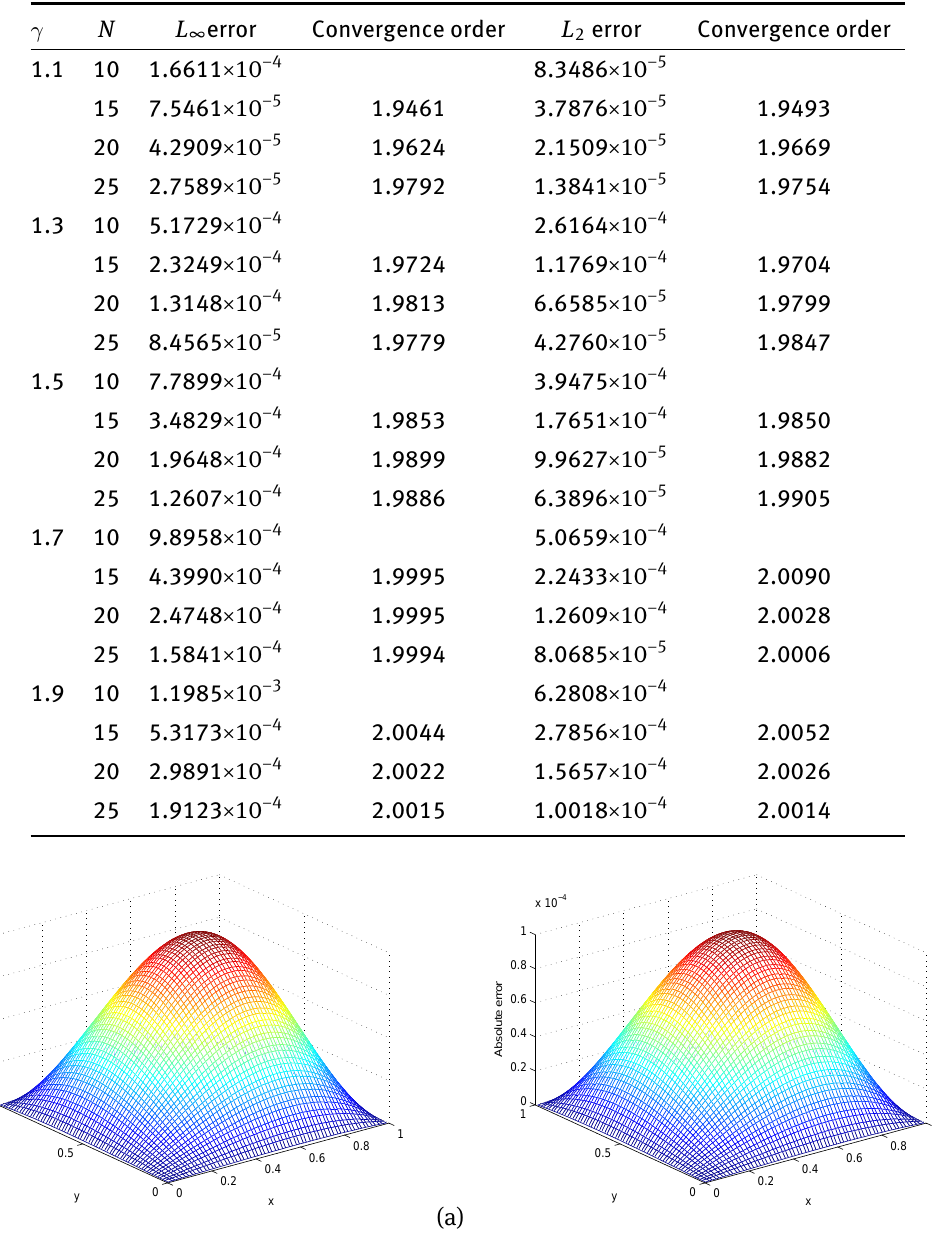
Table 5: The L ∞ , L 2 errors and temporal convergence orders for Example 3.